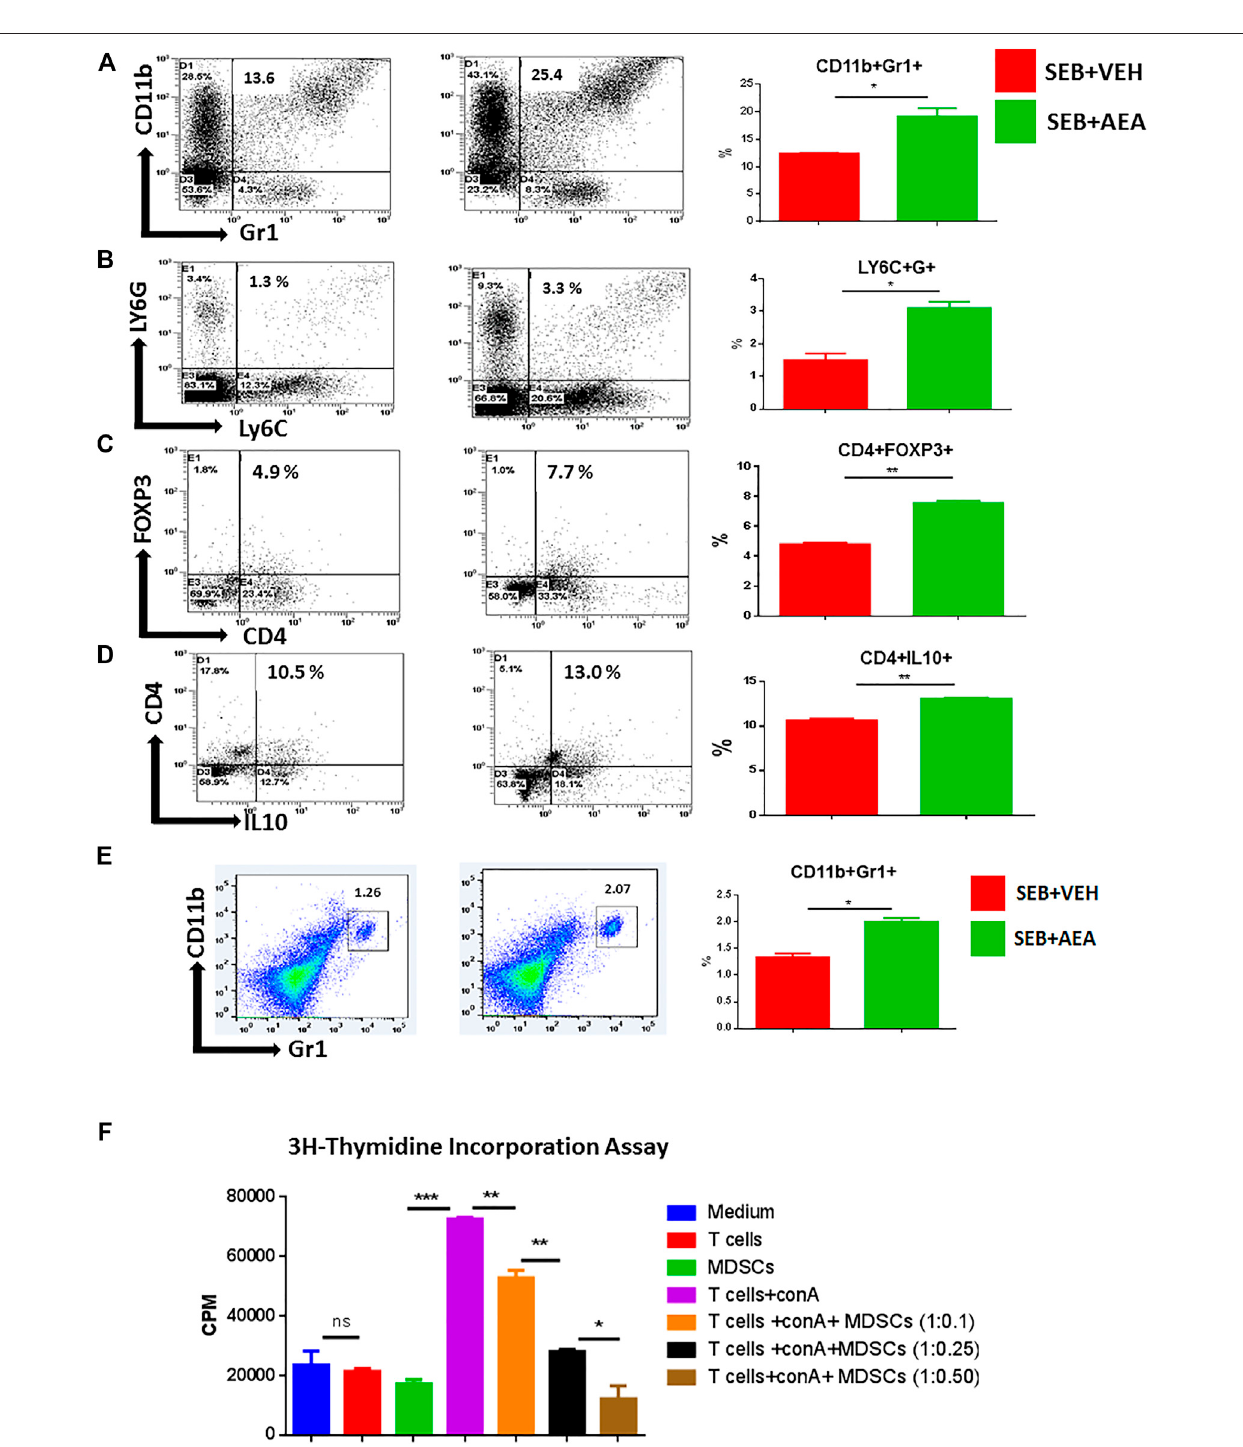
FIGURE8| AEAinducesMDSCsandTregsinthelungsofSEBadministeredmice.MiceweretreatedwithSEBandAEAasdescribedin Figure1 legend.Thelung MNCs were next stained for markers to detect MDSCs and Tregs. Each panel shows a representative experiment depicting lung MNCs analyzed for various T cell markers.Datafrom fi vemice/groupispresentedintheform ofvertical barswithMean+/-SEM. (A) Cellsdouble-stainedforCD11band Gr1.arepresentative experiment using fl ow cytometry. (B) Cells double-stained for LY6C and LY6G. (C) Cells double-stained for CD4 and FOXP3. (D) Cells double-stained for CD4 and IL10. (E) Cellsfromthespleensweredouble-stainedforCD11bandGr1.Verticalbarsshowdatafrom fi vemice. (F) AEA-inducedMDSCswereincubatedwithsplenicTcellsthat were activated with ConA at different ratios to create different Tcell:MDSC ratios. T cell proliferation was assessed by 3 H- Thymidine Incorporation Assay. Data from fi ve mice/group is presented in the form of vertical bars with Mean+/-SEM. * p ≤ 0.05, ** p ≤ 0.01, *** p ≤ 0.001.